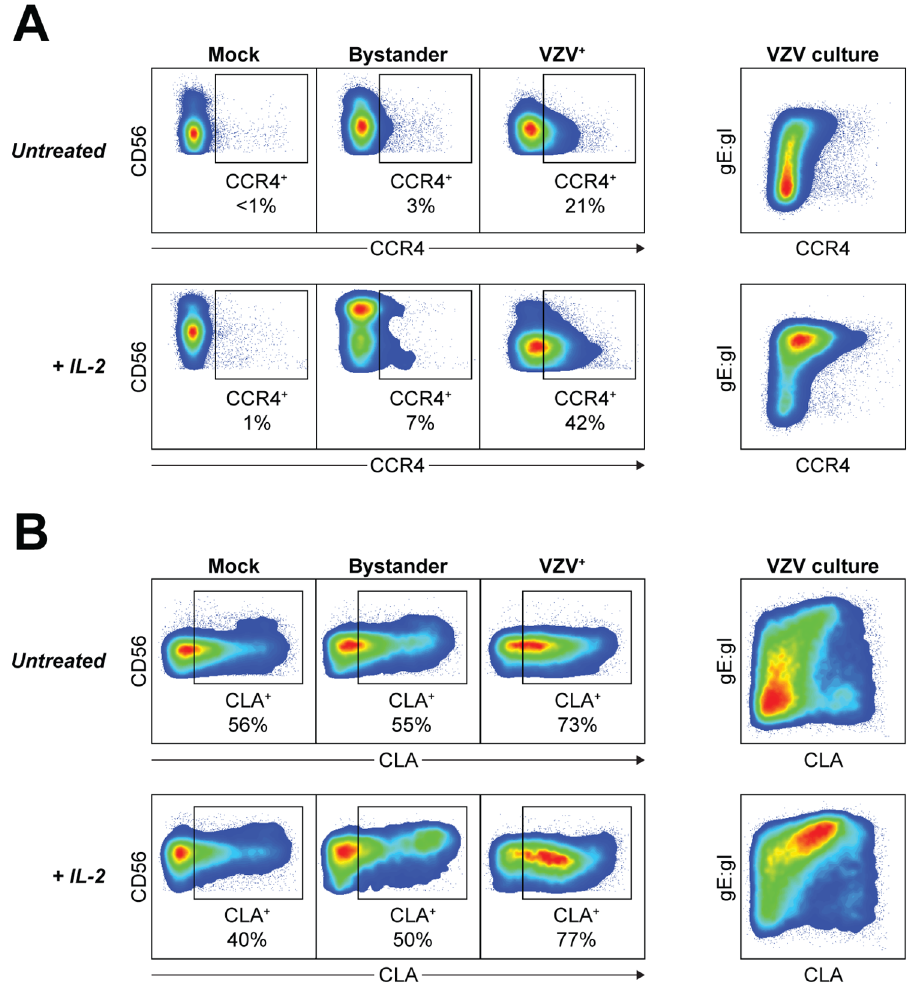
Fig 7. VZV upregulates expression of skin-homing chemokine receptors on NK cells. Healthy human donor PBMCs were mock or VZV infected with or without IL-2 (200 U/ml) for 2 days then analysed by flow cytometry. (Left panels) Representative plots show CCR4 (A) or CLA (B) expression against CD56 expression for mock, bystander and VZV + NK cells. (Right panels) Representative plots show CCR4 (A) or CLA (B) expression versus VZV gE:gI expression for VZV cultured NK cells. Data are representative of five